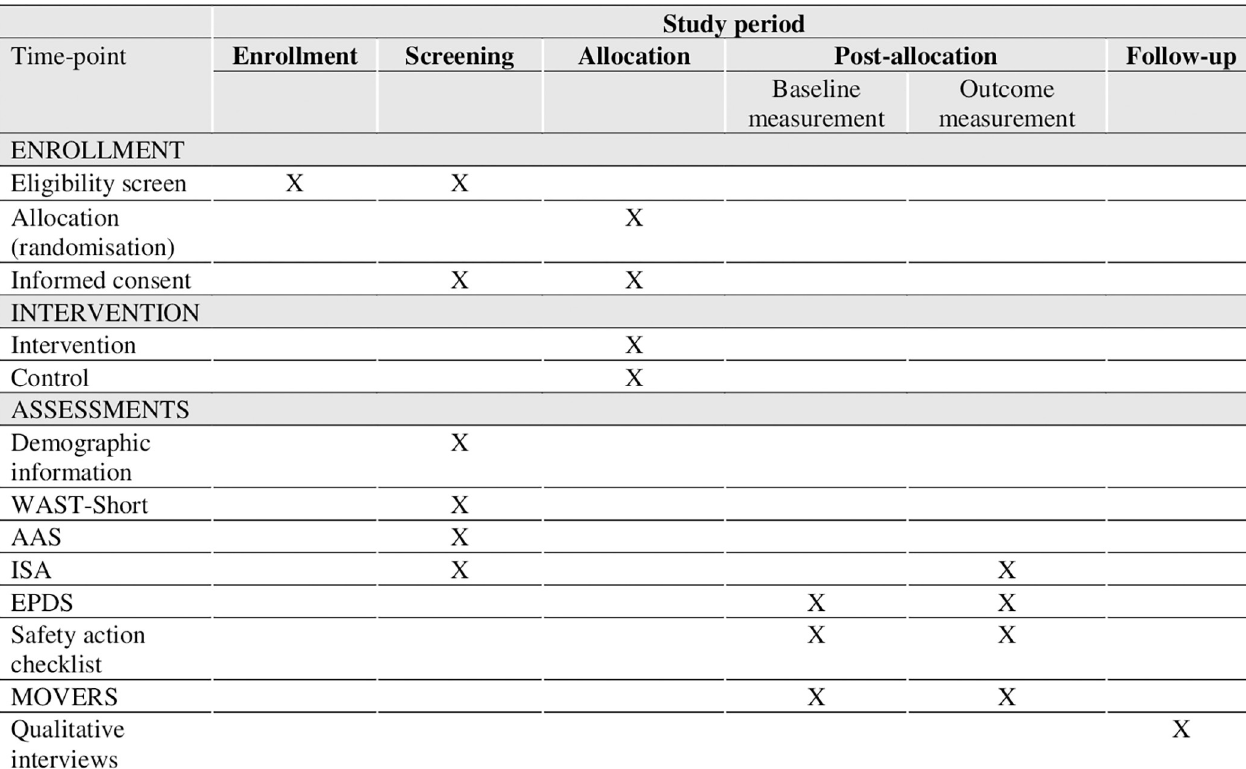
Fig 1. SPIRIT schedule of enrolment, interventions and assessments in eIPV trial.